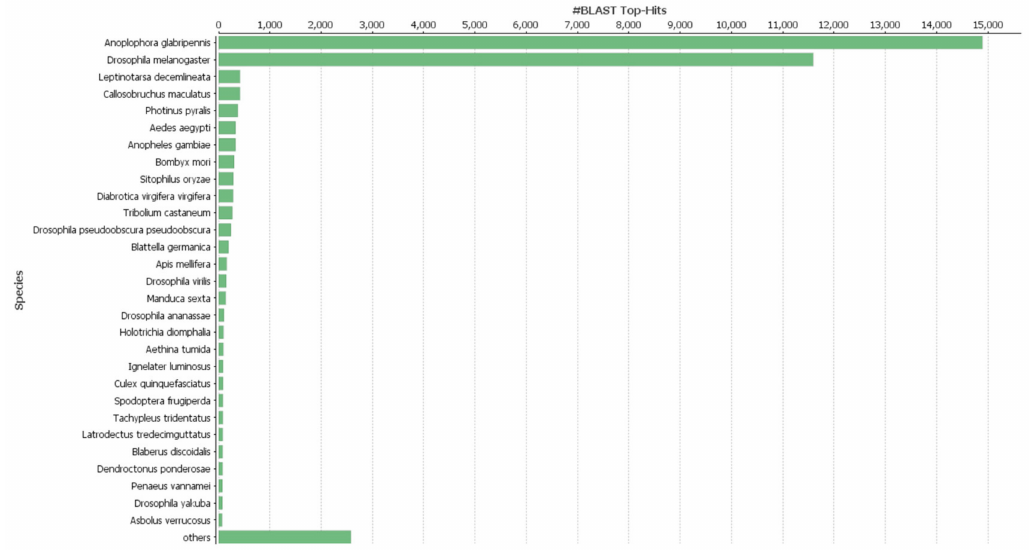
Figure 1. Blast Top hit species distribution match of Psacothea hilaris in Arthropoda